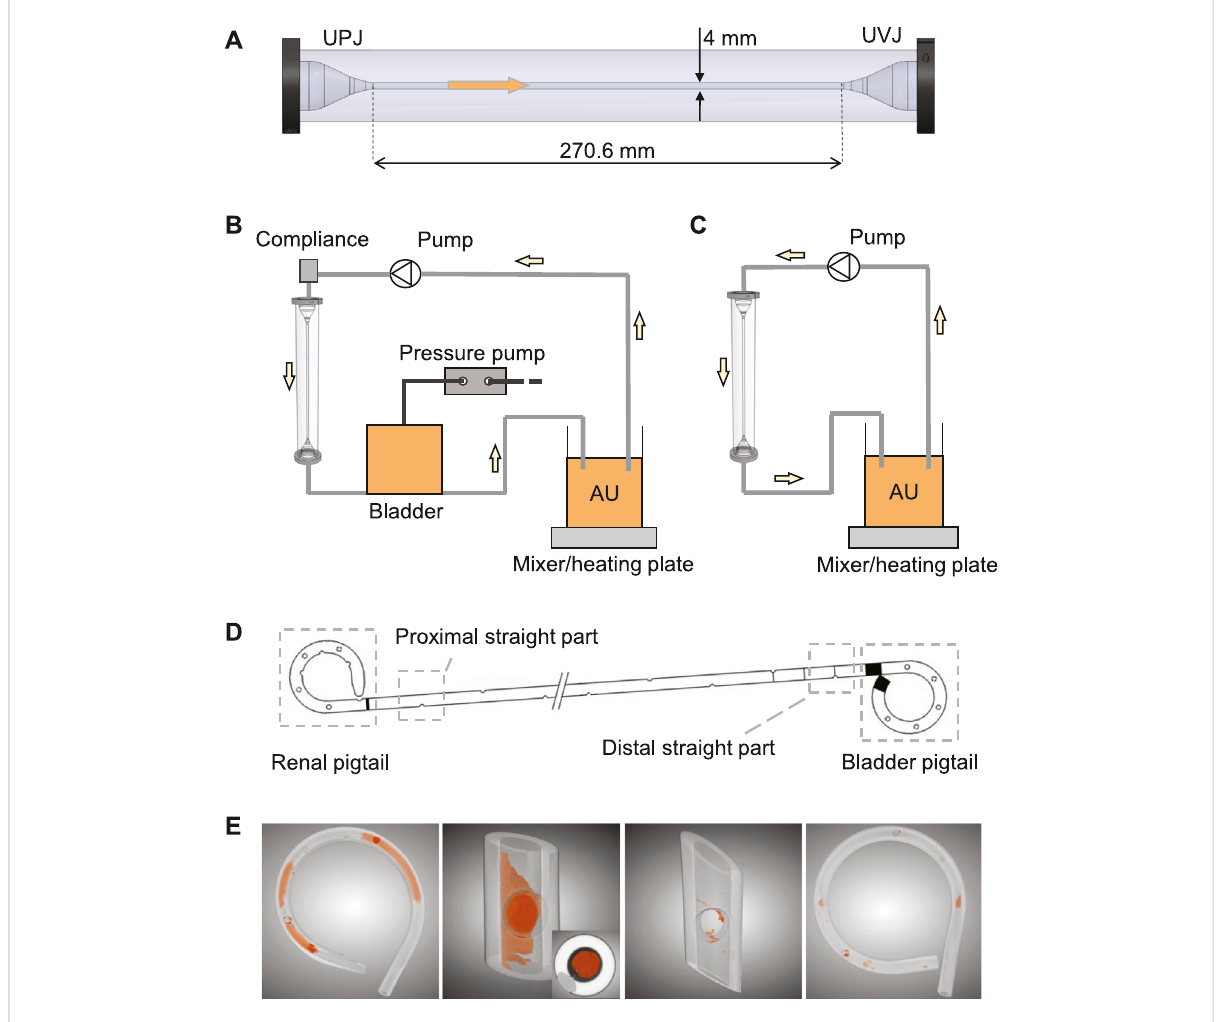
FIGURE 1 (A) TheuretermodelwithconicalendstosimulateUPJandUVJ.Thearrowshowsthe fl owdirection.Schematicsofthecomplete invitro setup with and without the bladder model are shown in (B) and (C) , respectively. (D) Illustration of the four sections of a stent chosen for this study. (E)